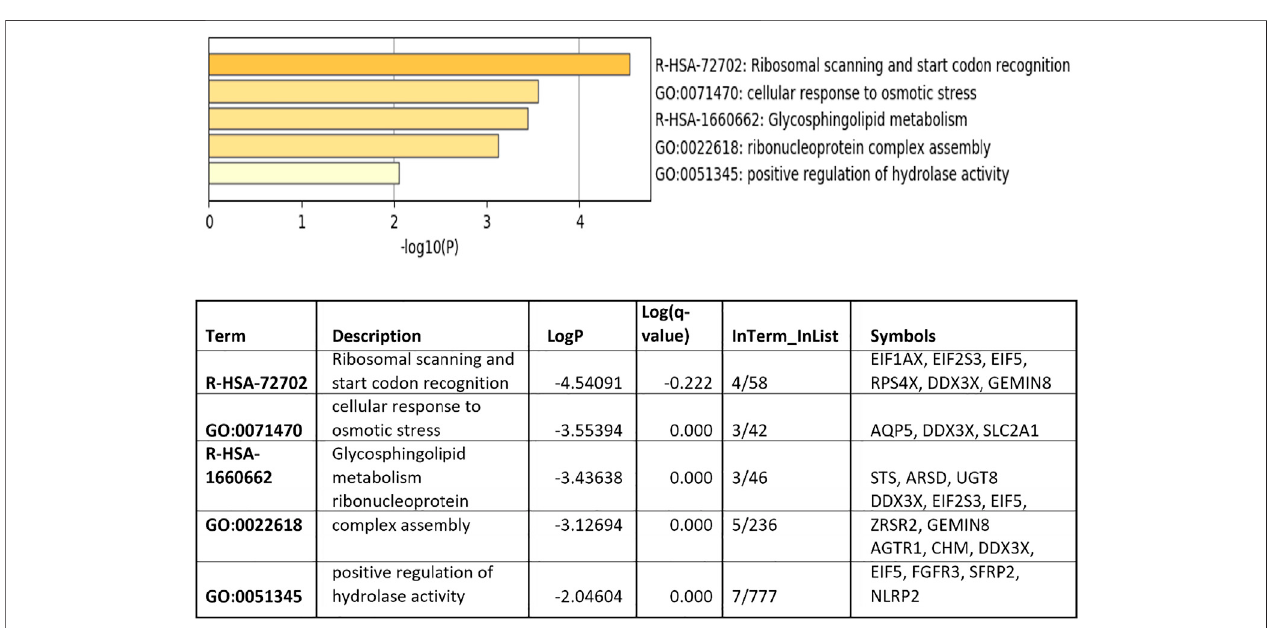
FIGURE 2 | Top pathway enrichment for the differentially expressed genes between males ’ and females ’ lung tissues. Genes related to the hydrolase activity are enriched in females ’ lung tissue compared to males ’ .